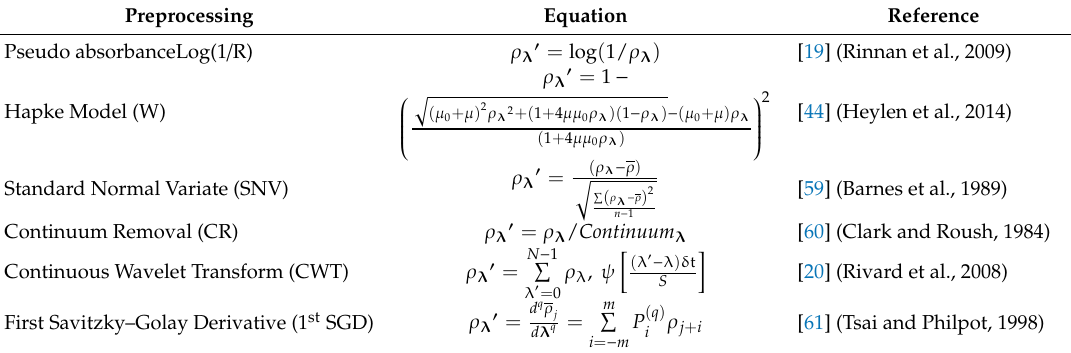
0 , cosinus of the , center of the j ( q ) . i